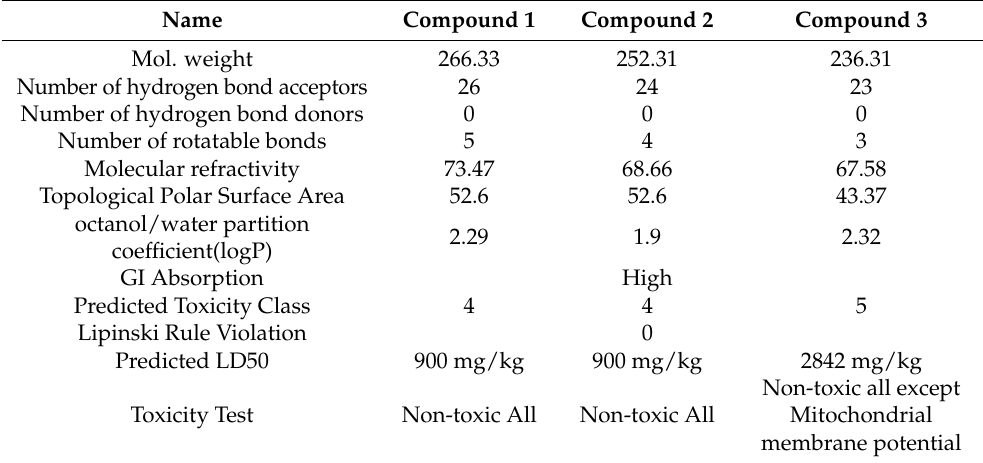
Table 4. Physical characteristics, drug likeliness and toxicity potential of Compound 1–3